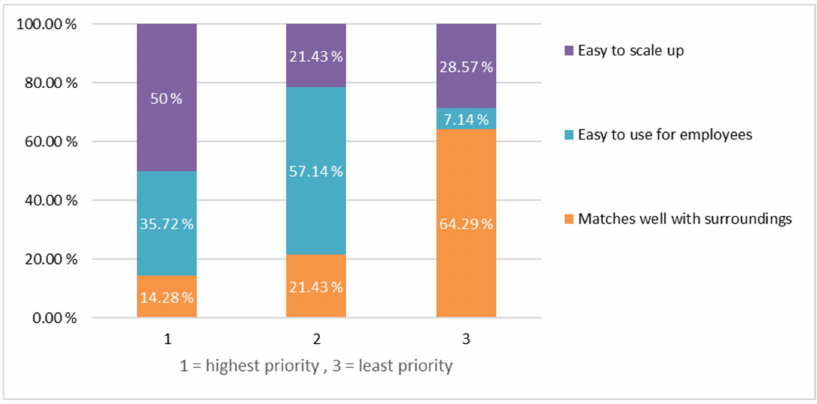
Figure 3. Ranking of the infrastructure characteristics.